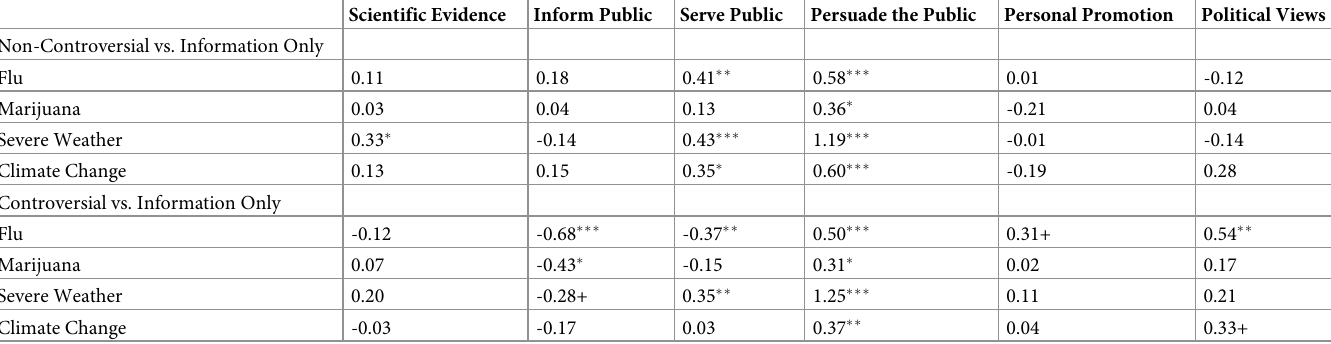
Table 3. Effect of solution position on perceived motivations of the scientist.